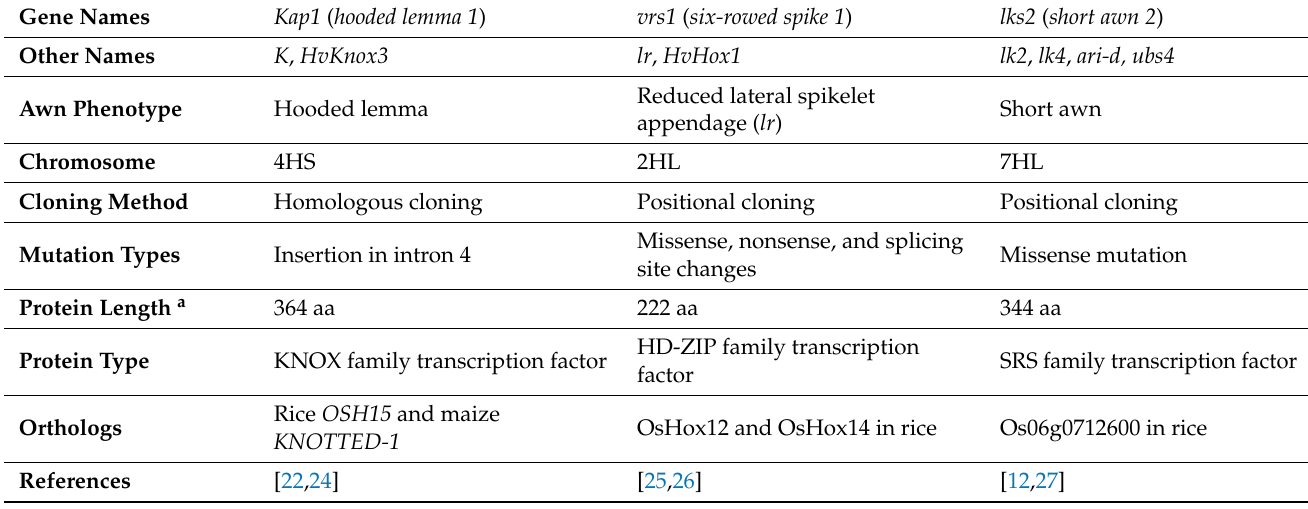
Table 1. Cloned awnness genes in